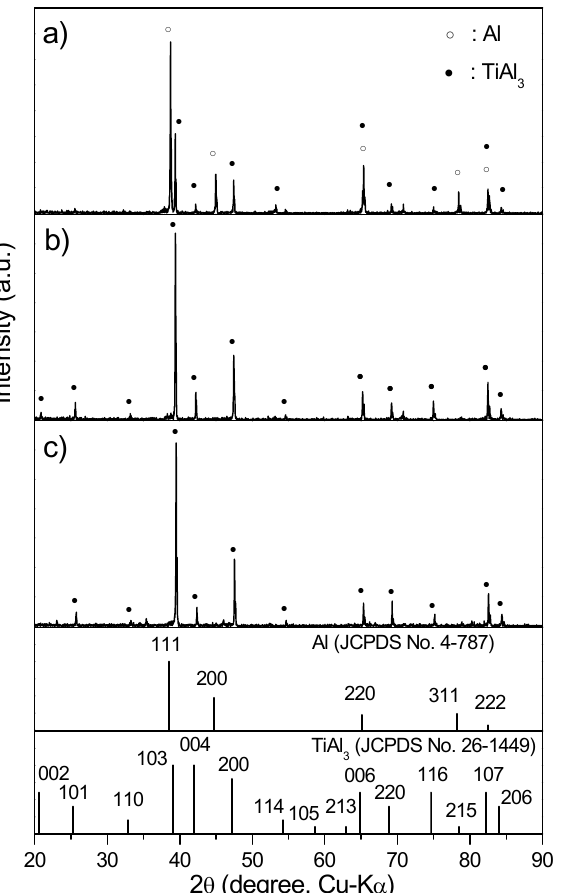
Figure 5. XRD patterns of the samples annealed at a) 650 °C, b) 700 °C and c) 1000 °C.